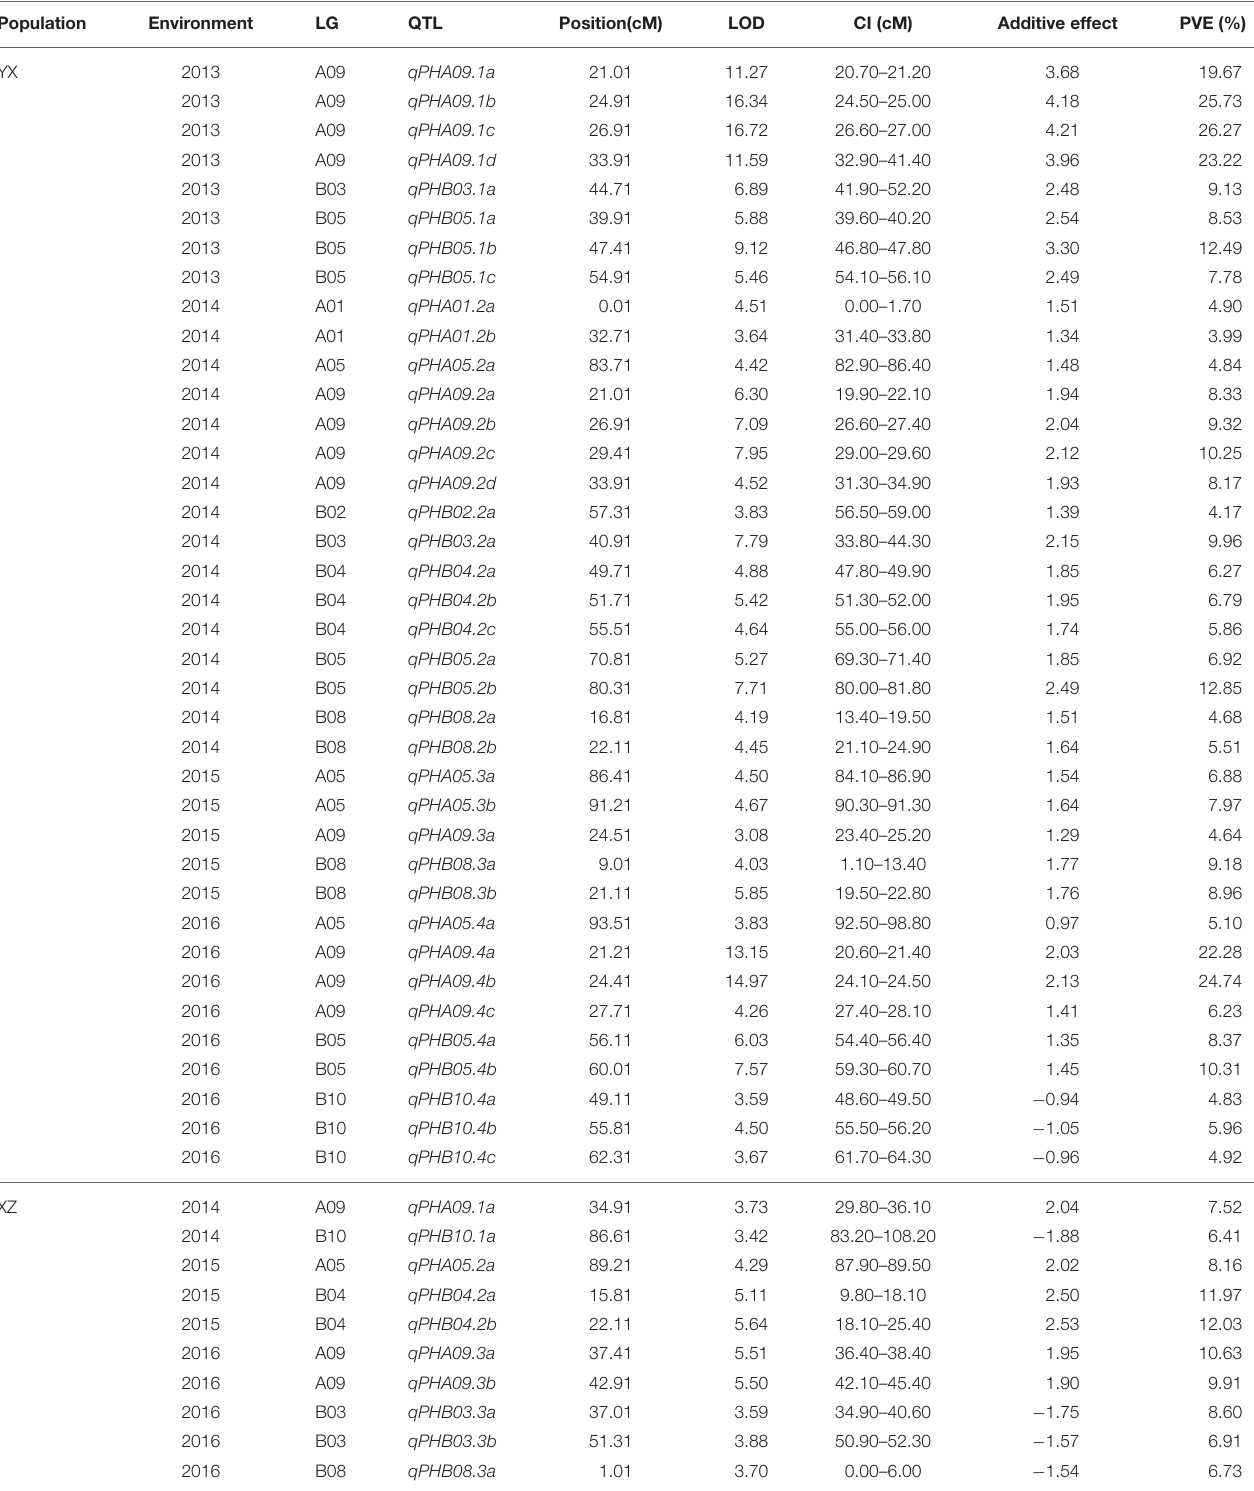
TABLE 3 | QTLs of plant height were detected in two populations across multiple environments. Population